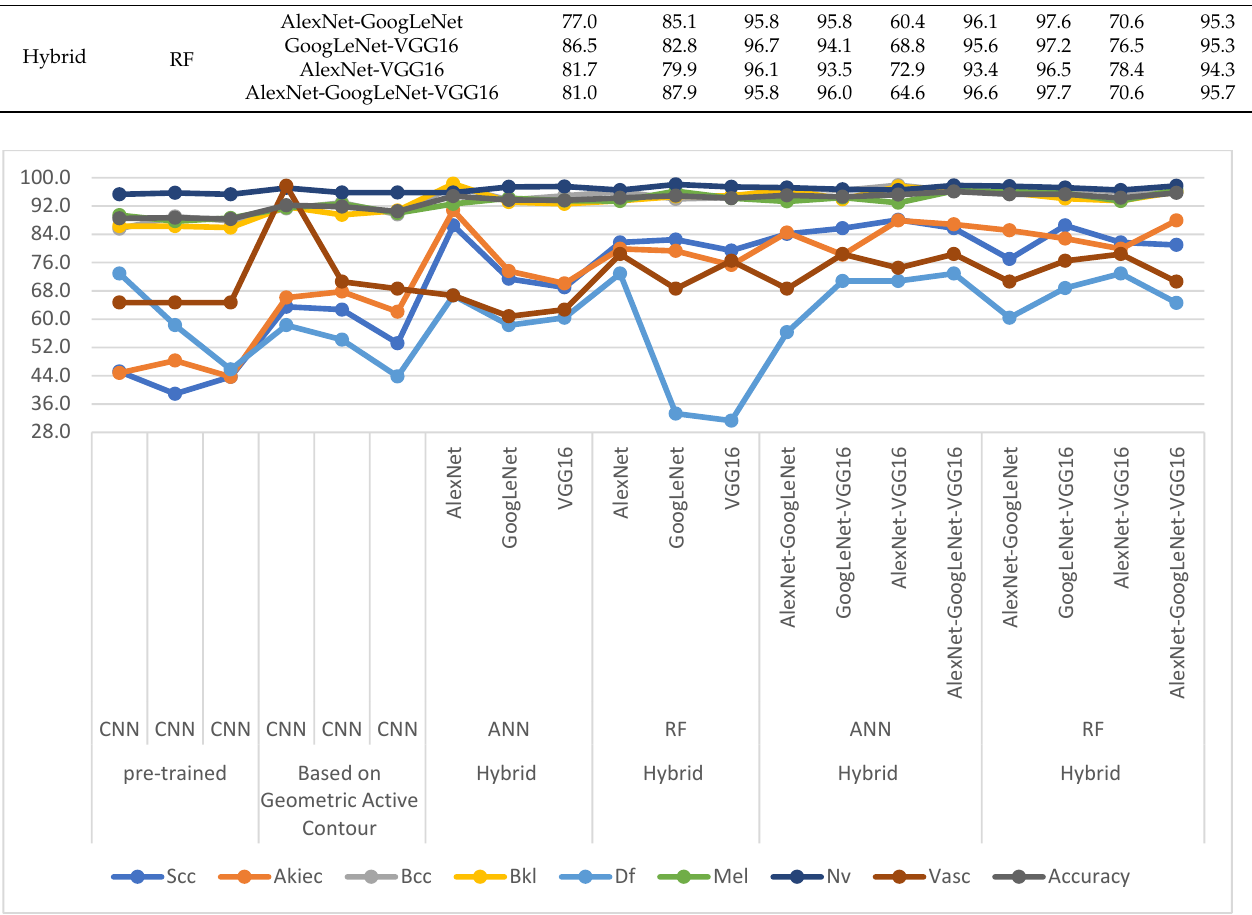
Figure 17. Performance of the proposed systems for dermatoscopic image analysis for early diagnosis of skin cancer for the ISIC 2019 data set and distinguishing them from other skin lesions.